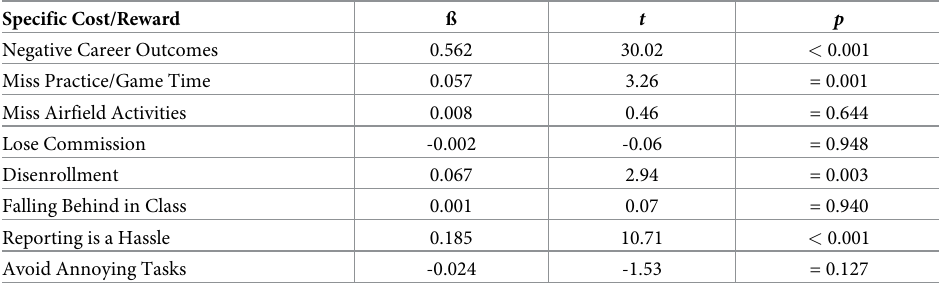
Table 3 shows the beta weight, t value, and p value for each specific cost and the one reward used to predict Perceived Cost in a simultaneous regression